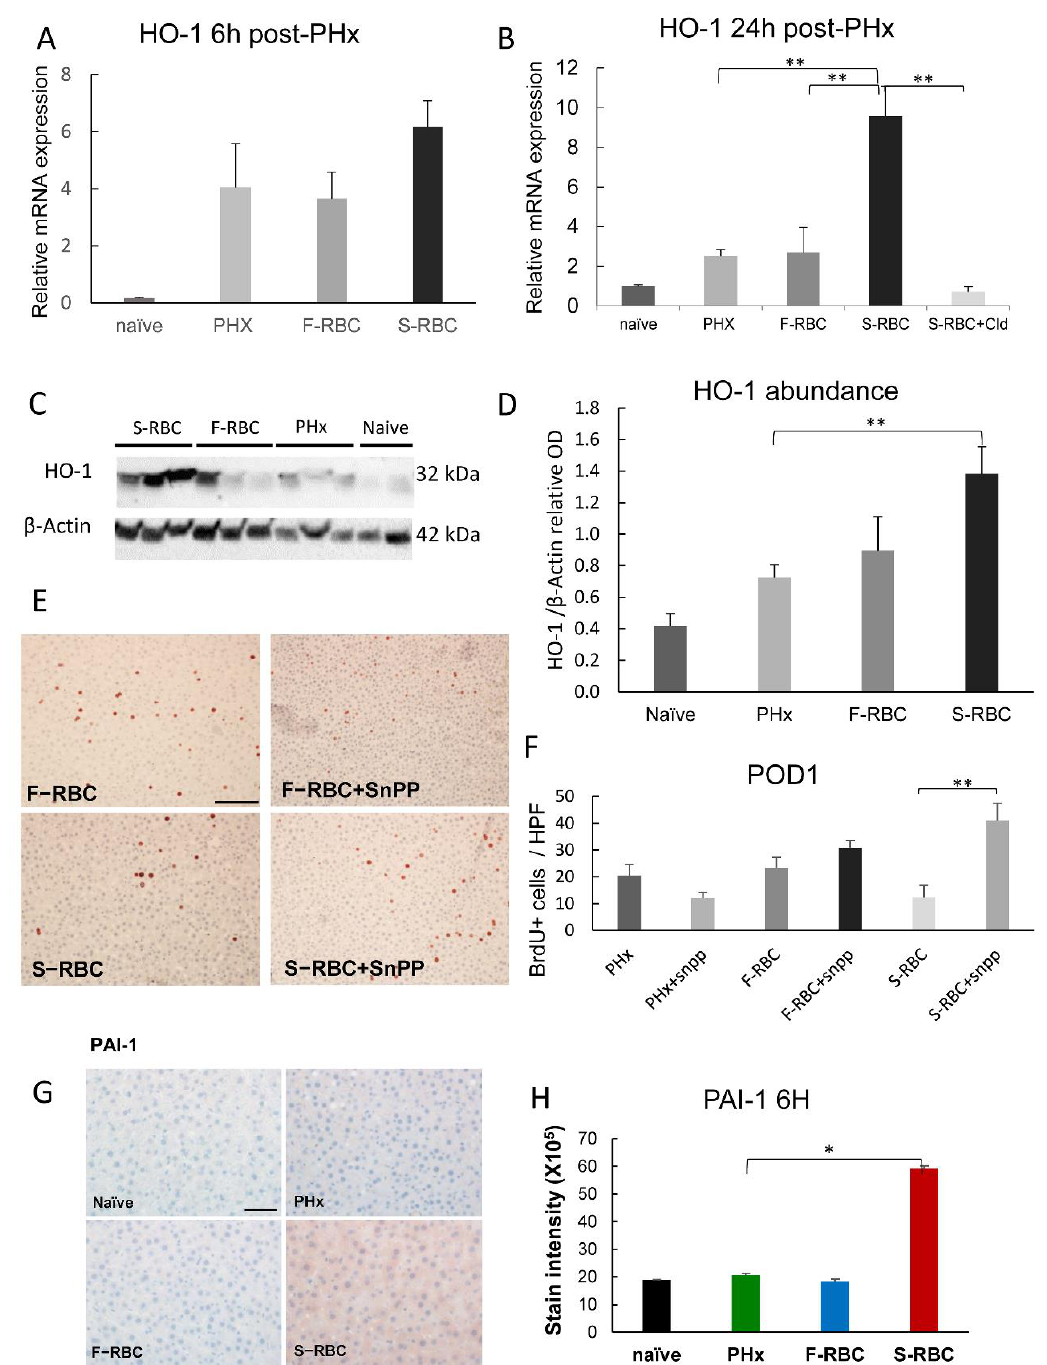
Figure 6. HO-1 upregulation in livers of rats following PHx and S-RBC transfusion. Hepatic HO-1 expression in the various groups at 6 h ( A ) or 24 h ( B ) post-PHx. ( C ) Western blot of HO-1 in the livers of the different groups following PHx. ( D ) Western blot quantification. ( E ) Representative images of BrdU staining showing hepatocyte proliferation in the various groups one day after PHx; Bar = 100 µ m and apply for all. ( F ) Quantification of the number of BrdU-positive cells per HPF. Snpp, an HO-1 inhibitor, was injected subcutaneously four hours prior to PHx. Average of 9 fields per animal from the different liver lobes. n = 5 – 15 per group. * p < 0.05, ** p < 0.01. ( G ) Representative images of PAI-1 hepatic staining in the various groups from samples obtained six hours post-PHx; Bar = 50 µ m and apply for all. ( H ) Quantification of staining intensity. Average of 10 fields per animal, n = 6 rats per group; * p < 0.05.